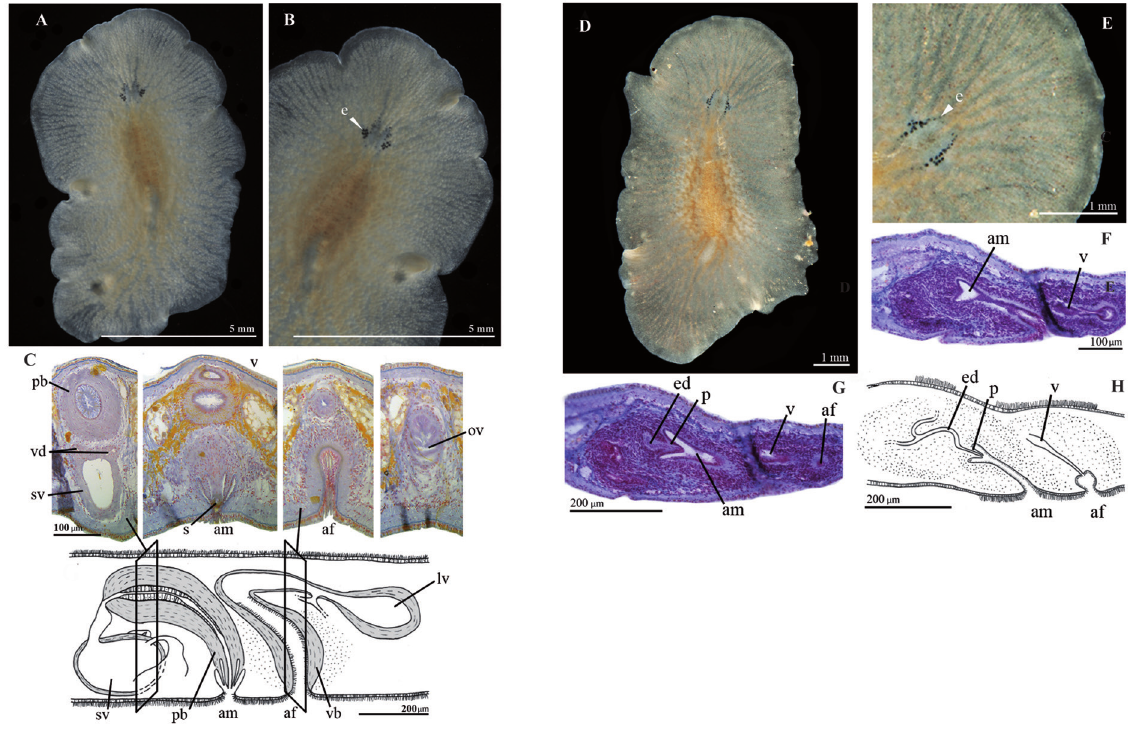
Fig. 4. A–C . Parviplana sodade sp. nov. (MNCN 4.01/2699 to 2708). A . Whole live animal, dorsal view. B . Anterior region with eyes cluster and tentacles (white arrows). C . Histological cross sections of male and female copulatory organ stained with AZAN and sagittal reconstruction of the reproductive system. – D–H . Euplana claridade sp. nov. (MNCN 4.01/2709 to 2718). D . Whole live animal, dorsal view. E . Anterior region with cerebral eyes cluster and tentacles (white arrows). F . Histological section of female copulatory organ stained with AZAN. G . Histological section of male copulatory organ stained with AZAN. H . Sagittal reconstruction of reproductive system. Abbreviations: see Material and